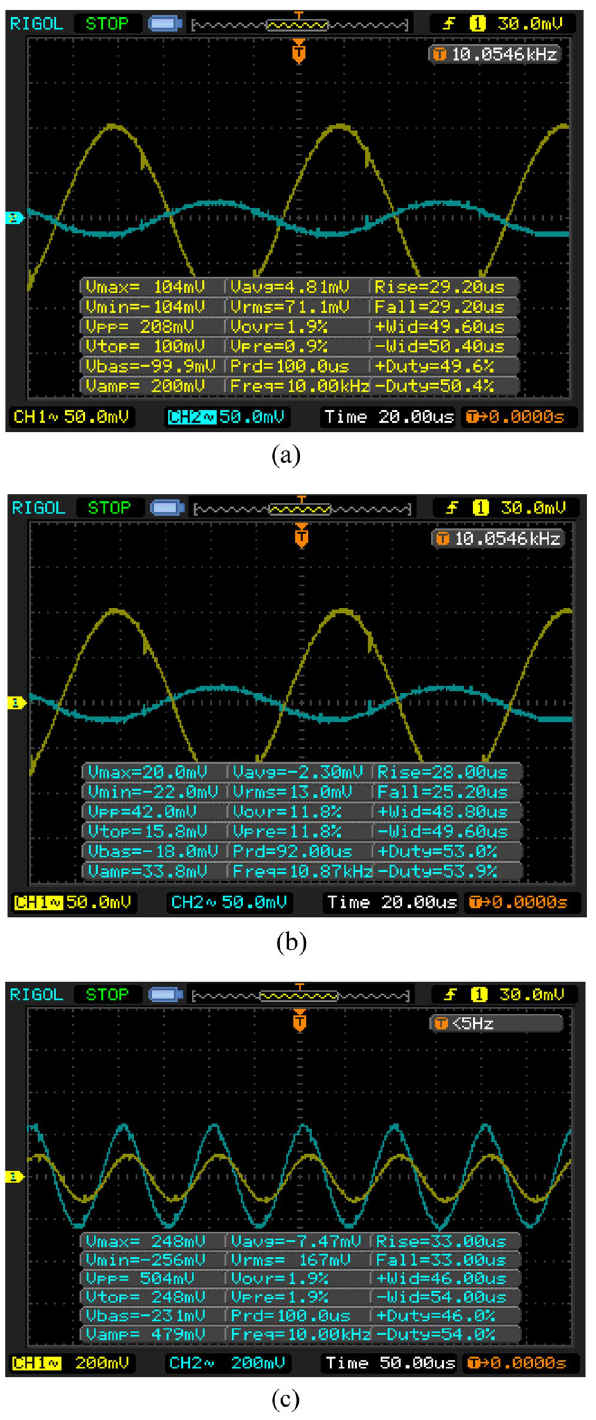
Fig. 14 Common-mode output signal for proposed differential